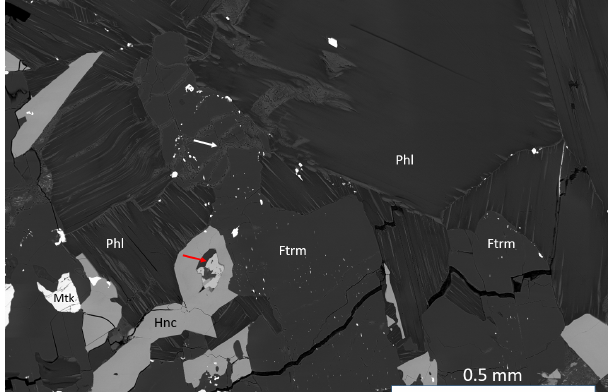
Figure 2. BSE-SEM image of ferri-taramite (Ftrm), with phlogo- pite (Phl), hancockite (Hnc) and melanotekite (Mtk). The atoll-like hancockite grain contains calcite and baryte (red arrow). The white arrow points to prehnite. White specks in the amphibole crystal are inclusions of macedonite. Sample GEO-NRM